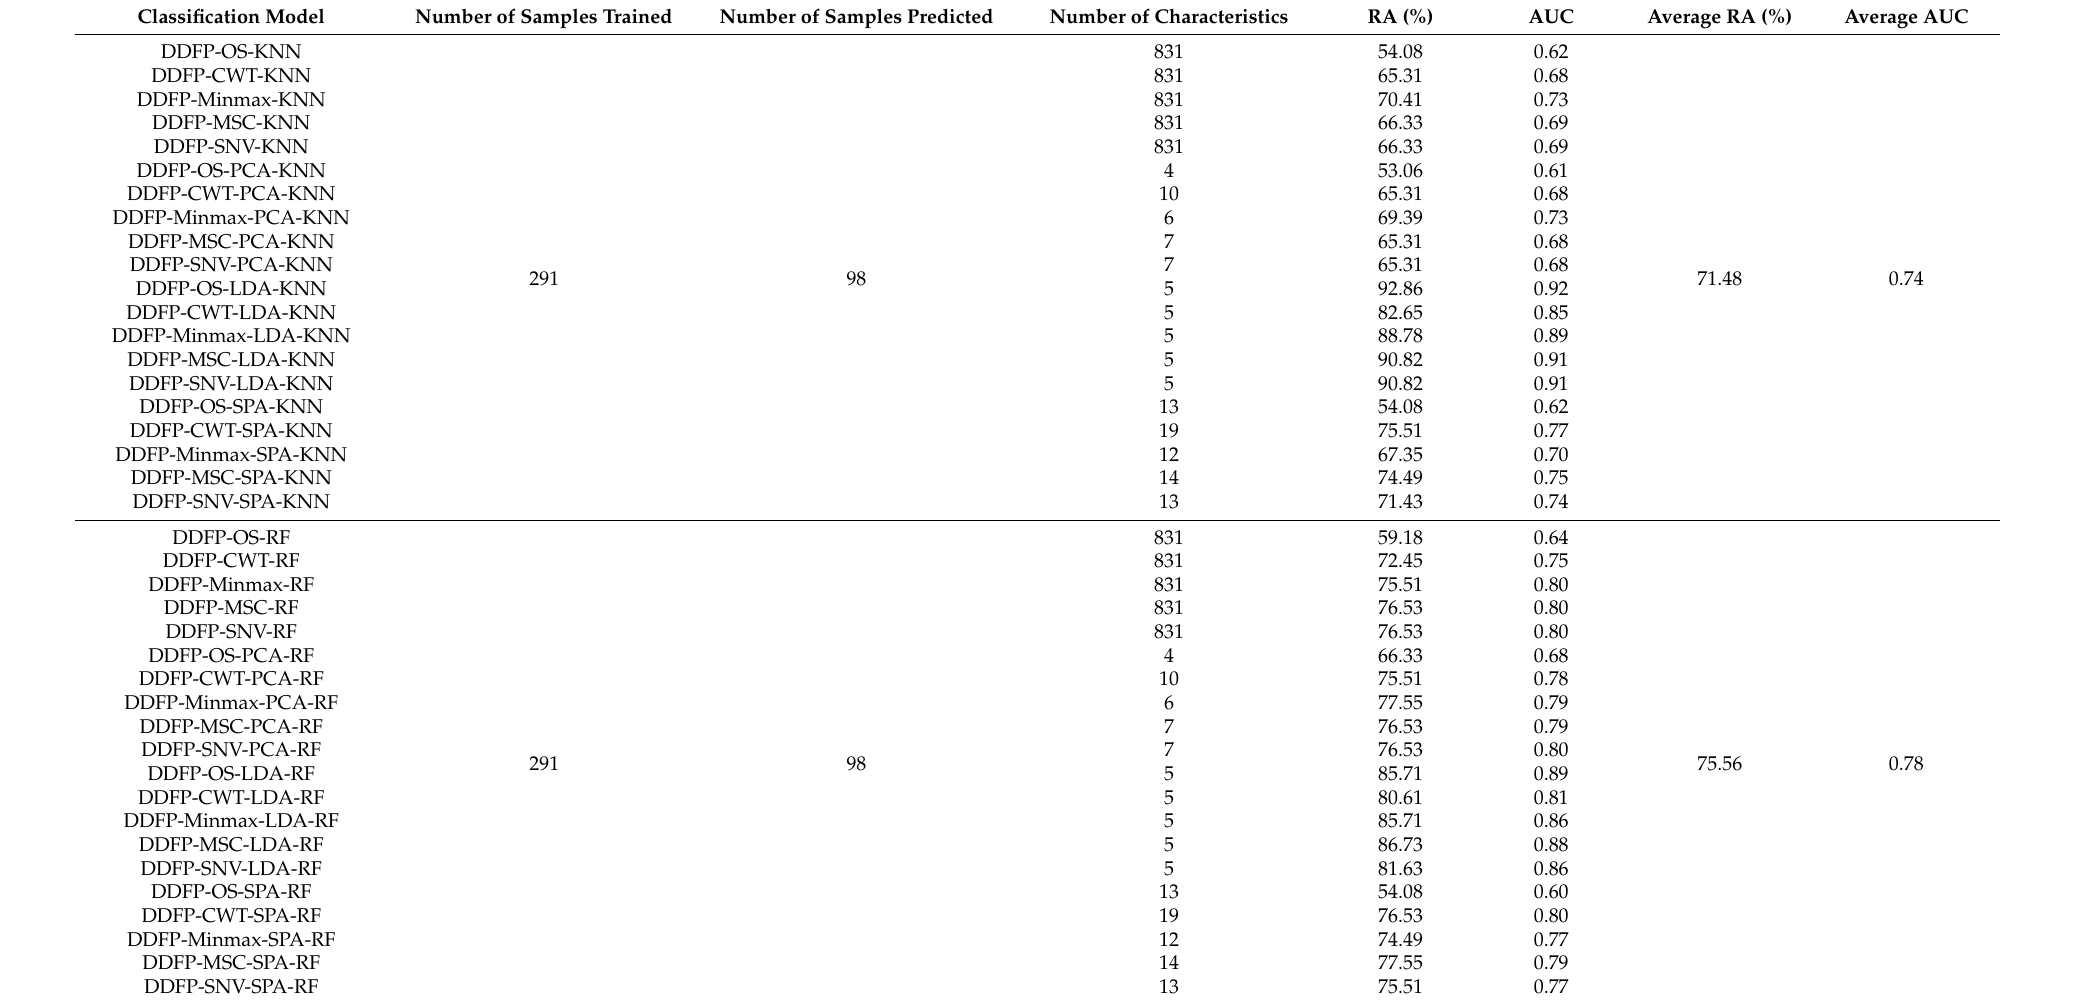
Table 3. Performance evaluation of traceability models of white tea classified by